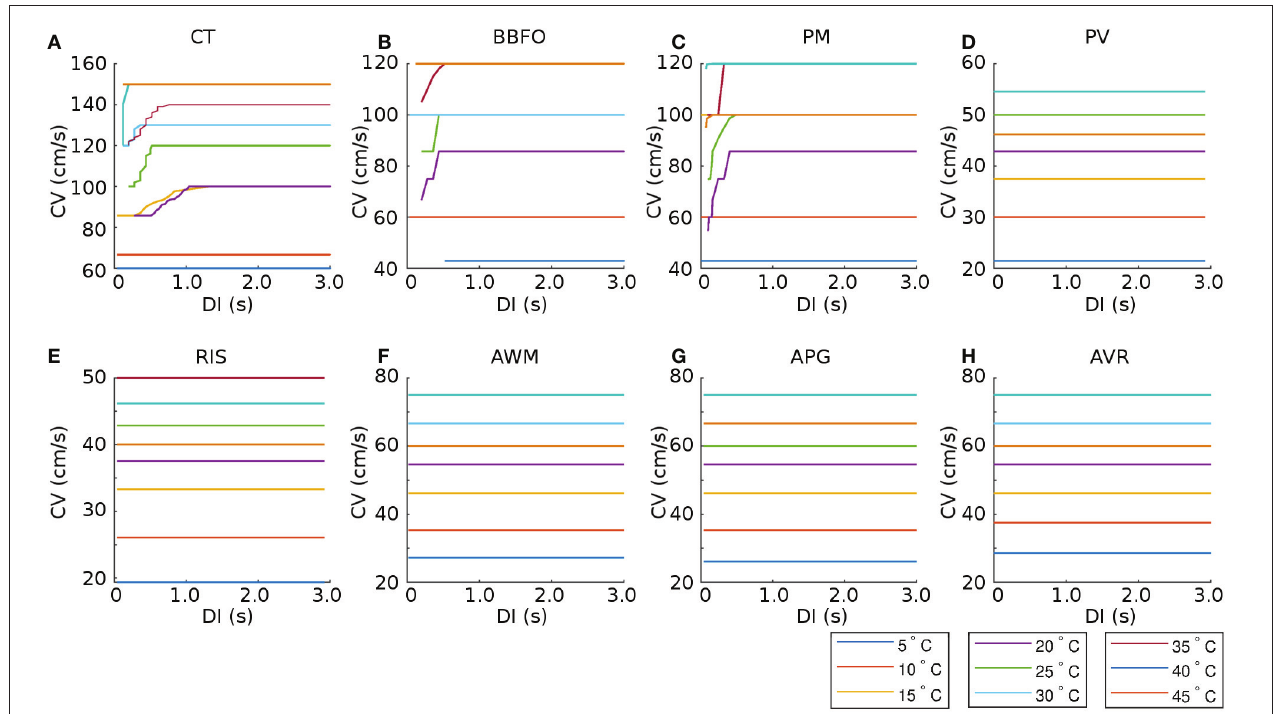
FIGURE 7 | Temperature-dependence of CV restitution curves recorded from (15.36 × 3 mm) tissue strips containing cells from (A) CT, (B) BBFO, (C) PM, (D) PV, (E) RIS, (F) AWM, (G) APG, and (H) AVR, respectively. Restitution was measured using the dynamic S1-S2 protocol (see section 2 for details). Our results show that CV is more or less independent of DI for most regions (PV, RIS, AWM, APG, and AVR), at all temperatures. However, in some regions (CT, BBFO, and PM), CV exhibits initial fluctuations at low DI at moderate